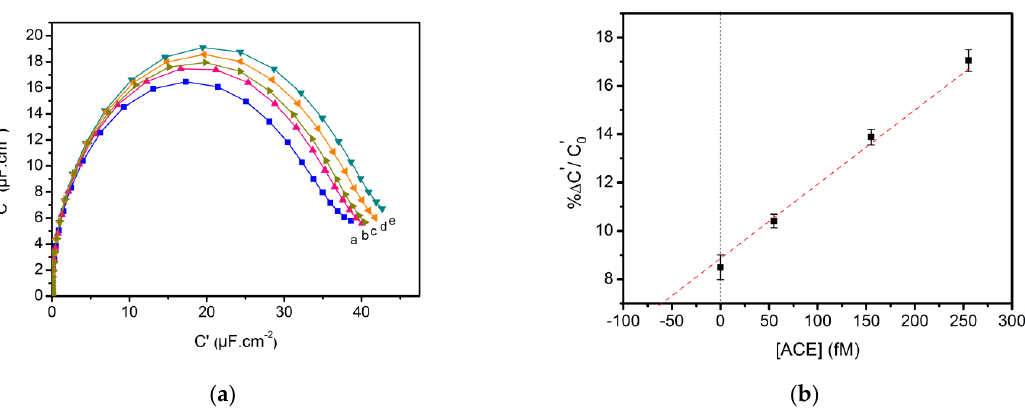
Figure 6. ( a ) Capacitance curves before (a: 0 fM) and (b to e) after incubation with various acetamiprid concentrations in fortified tomatoes samples (b: c i , c: c i + 55 fM, d: c i + 155 fM and e: c i + 255 fM); ( b ) Calibration curve of the biosensor displaying the relative variation of redox capacitance versus the target concentration. Table 2. Recovery data for acetamiprid in fortified tomatoes sample.